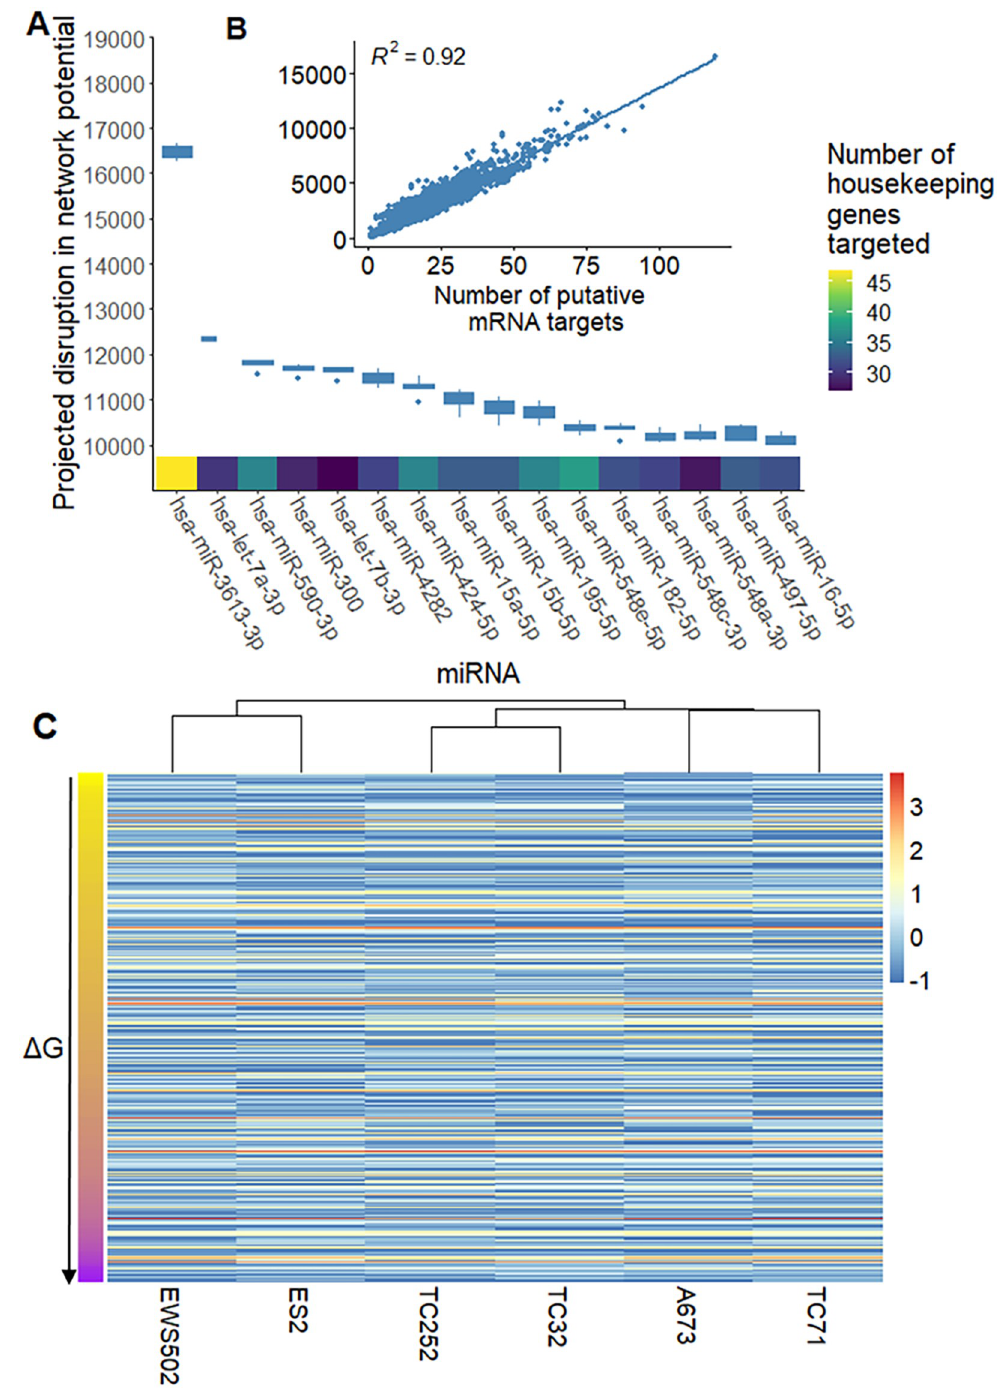
Fig 5. Many of the most promising miRNA candidates repress large numbers of essential housekeeping genes. We identified the top miRNA for treatment of Ewing sarcoma, ranked by their predicted disruption of the Ewing sarcoma cell signaling network. A : Boxplot showing the projected disruption in network potential for the top miRNA candidates (averaged across all samples). The heatmap on the x-axis describes the number of essential housekeeping genes that each miRNA is predicted to target. B : Scatterplot showing the relationship between projected network disruption and the number of putative mRNA targets for a given miRNA. C : Heatmap showing z-score normalized miRNA expression for 622 of the evaluated miRNA for the 6 cell lines under study. The Y axis is clustered by the projected Δ G associated with a given miRNA. There doesn’t seem to be a clear pattern of miRNA expression based on projected Δ G .